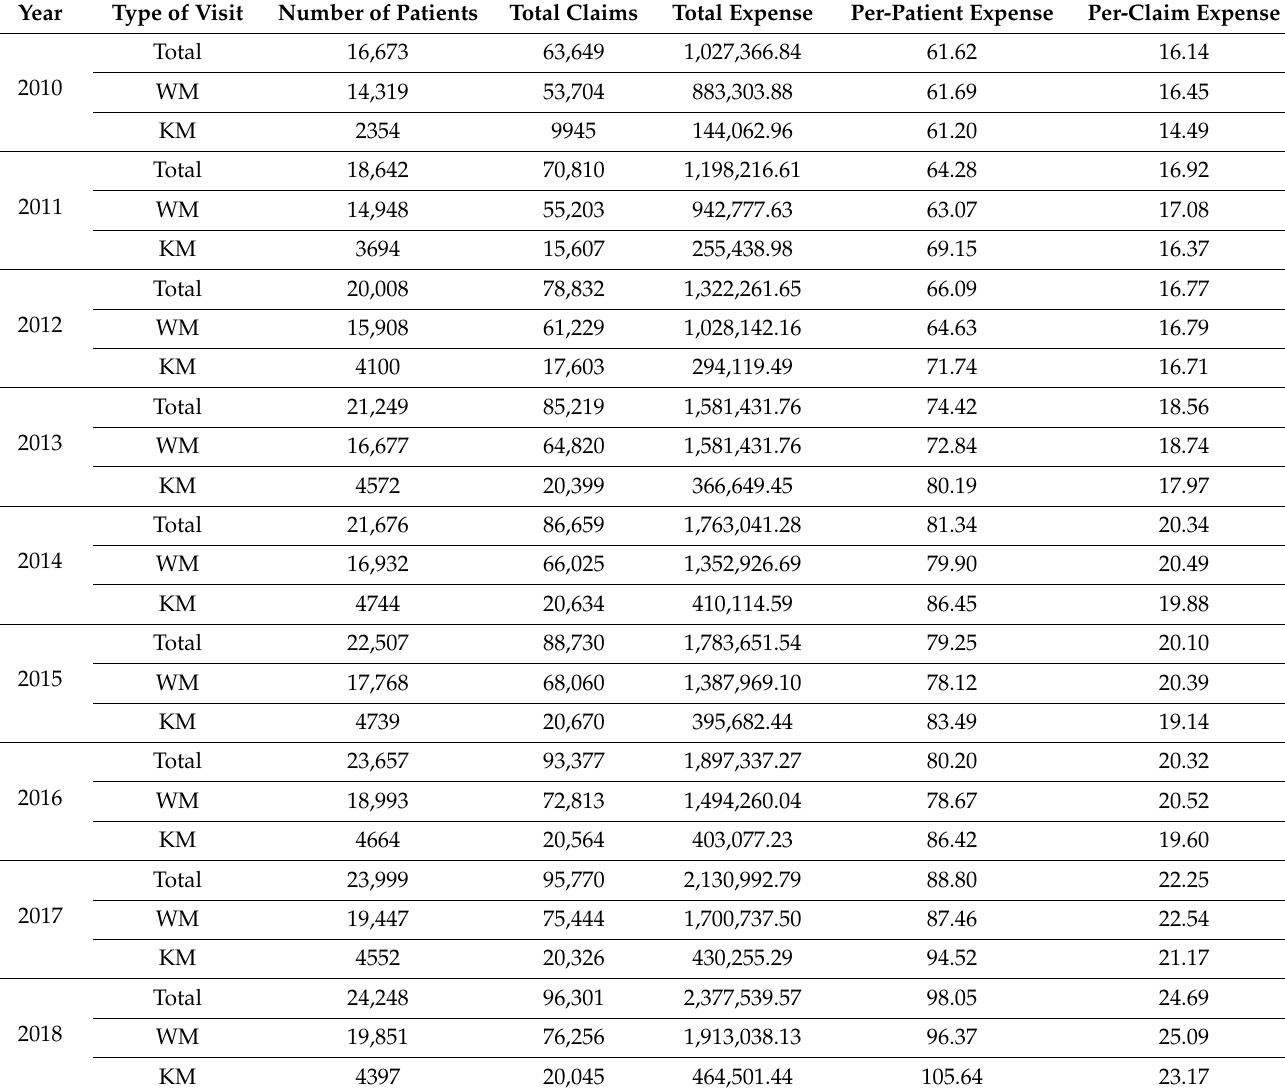
Table 1. General medical service use for lateral epicondylitis patients in